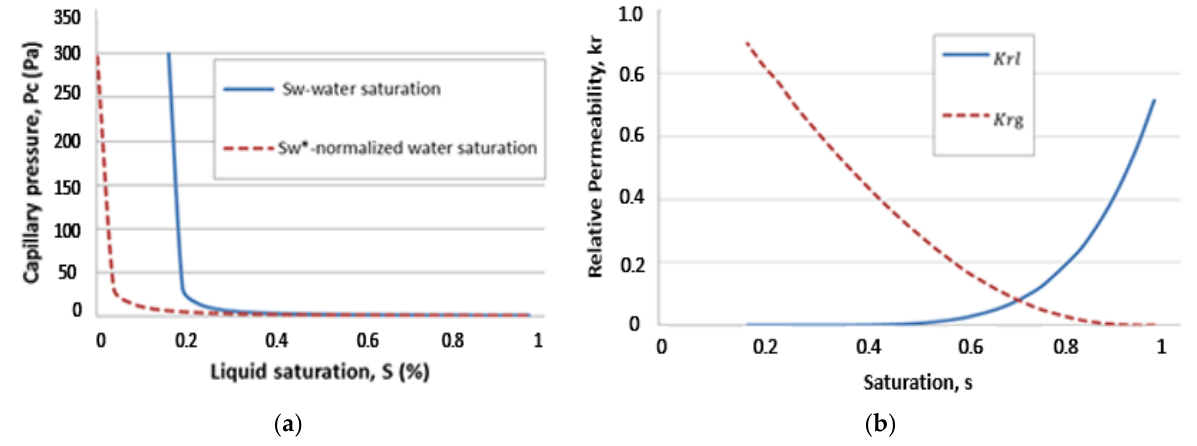
Figure 5. ( a ) Capillary pressure vs. liquid saturation, ( b ) relative permeability vs. saturation.